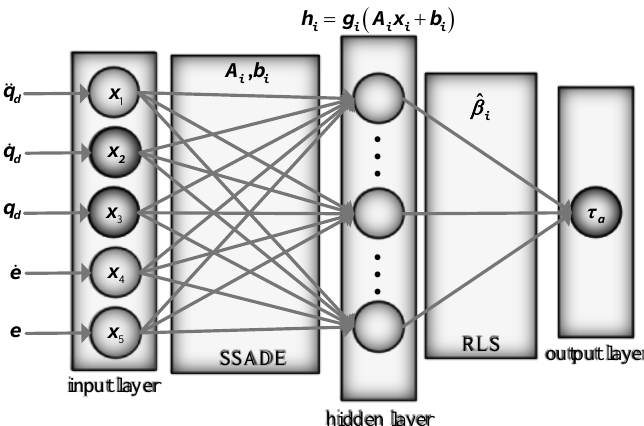
Figure 3. Diagram of adaptive control algorithm based on Strategy Self-Adaptation Differential Evolution–Extreme Learning Machine (SSADE–ELM). τ ai τ ci